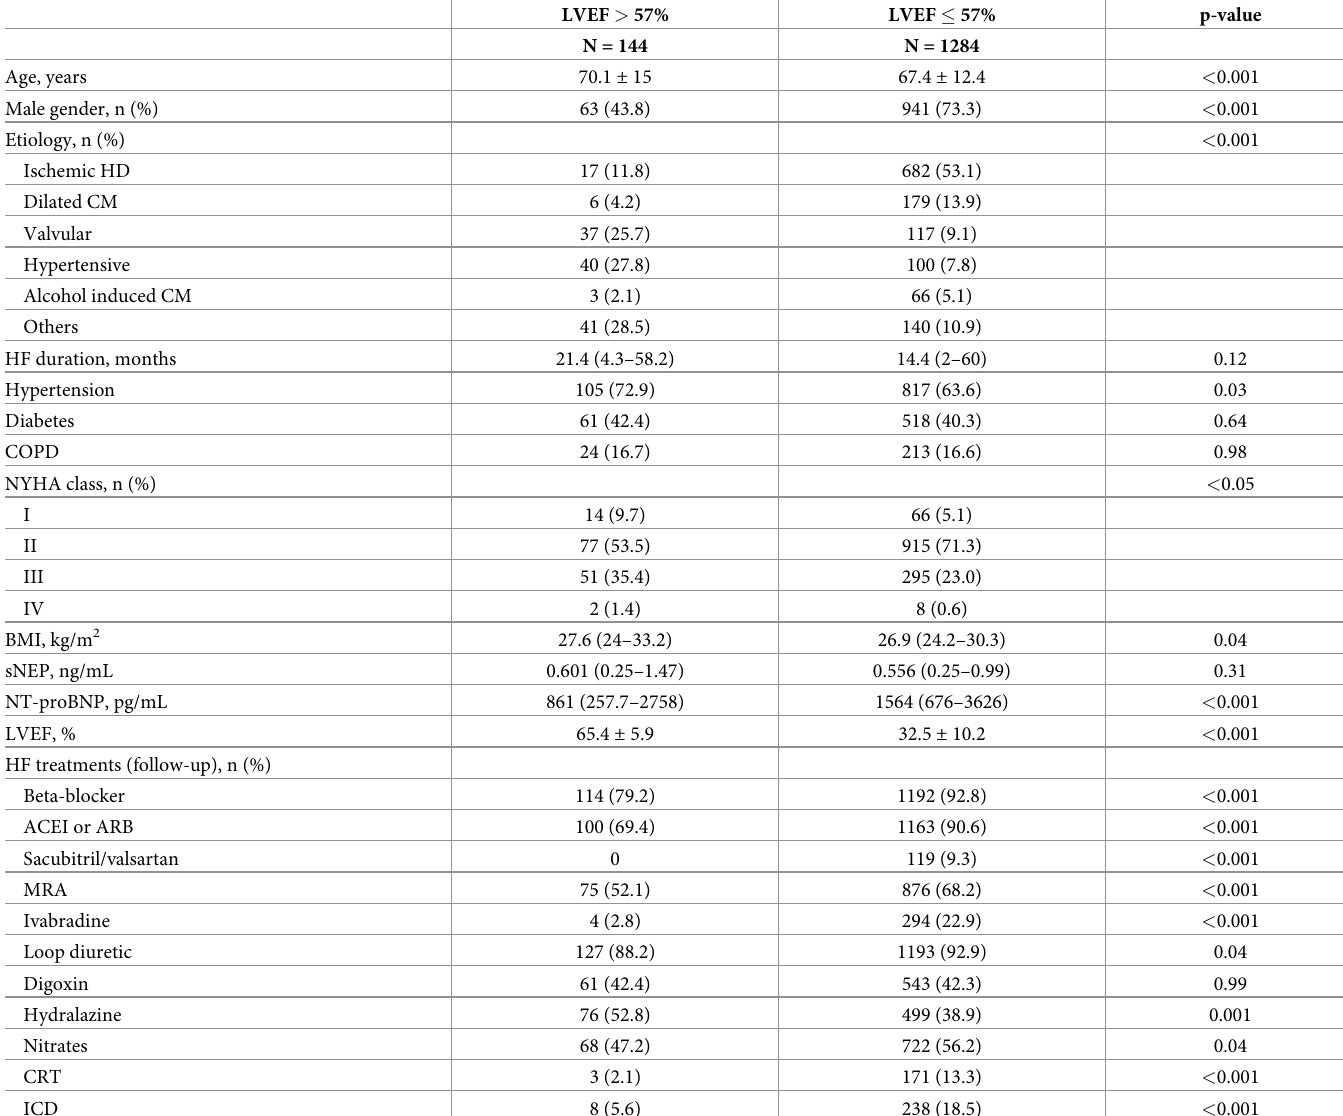
Table 1. Demographic and clinical